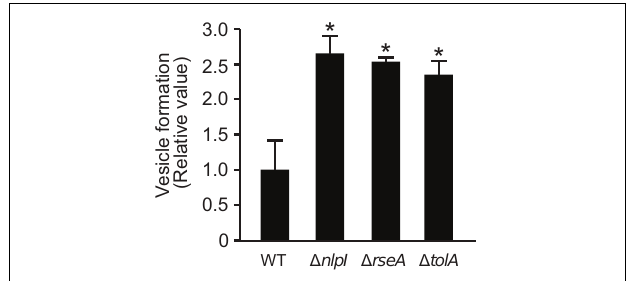
FIGURE 1 | Vesicle formation from E. coli BW25113 and mutants. WT, (cid:49) nlpI , (cid:49) rseA , and (cid:49) tolA , all harboring plasmid pUC19, were grown in LB medium containing ampicillin overnight. The amount of vesicles extracted from the supernatants was normalized to cell density, and each value shown is relative to that of WT. The data are presented as the mean ± standard deviation from three replicates. *P < 0.05 compared to WT.